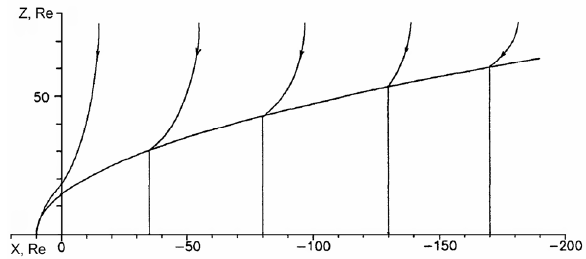
Figure 2. Plasma flow lines and magnetic field lines in the y=0 plane. The X axis is the Earth- Fig. 2. Plasma flow lines and magnetic field lines in the y =0 plane. Sun line, the Z axis is parallel to the IMF vector upstream of the bow shock. This coordinate The x-axis is the Earth-Sun line, the z-axis is parallel to the IMF system can be obtained from the solar-magnetospheric coordinates by a rotation around the X axis. In solar-magnetospheric coordinates, the IMF vector is { Bx , By , Bz }. In IMF- vector upstream of the bow shock. This coordinate system can be magnetospheric coordinates the IMF vector is { Bx , 0, Bt } where 22 zyt BBB += . obtained from the solar-magnetospheric coordinates by a rotation around the x-axis. In solar-magnetospheric coordinates, the IMF vector is { B x , B y , B z } . In IMF-magnetospheric coordinates the q B 2 y + B 2 z . IMF vector is { B x , 0, Bt } , where B t =